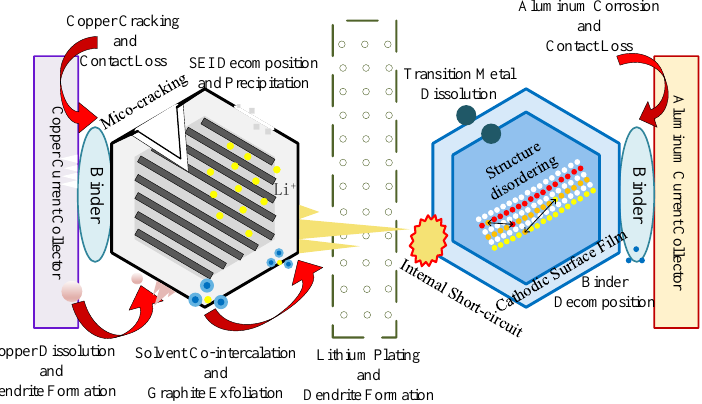
Figure 1. LIB internal activities.